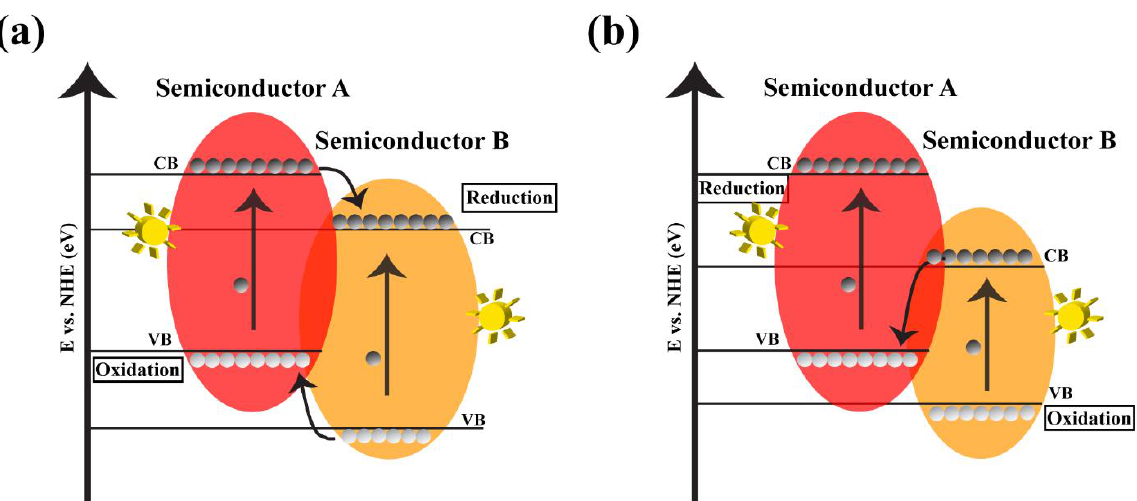
Figure 8. The two most common heterojunction types in g-C 3 N 4 – metal oxide photocatalysts: ( a ) type II heterojunction, ( b ) Z-scheme heterojunction (white and dark balls are holes and electrons, respec- tively).